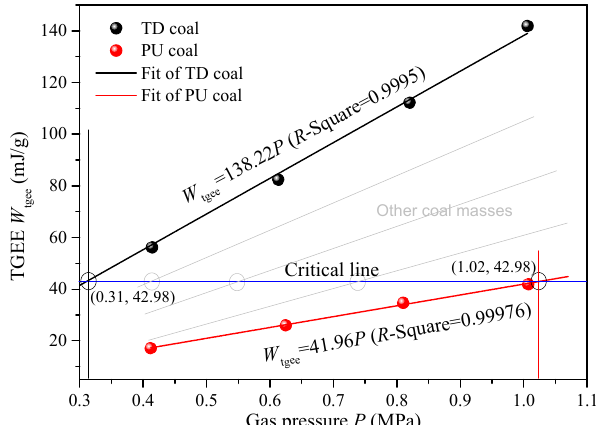
Figure 13. The critical conditions of outburst risk of different coals.